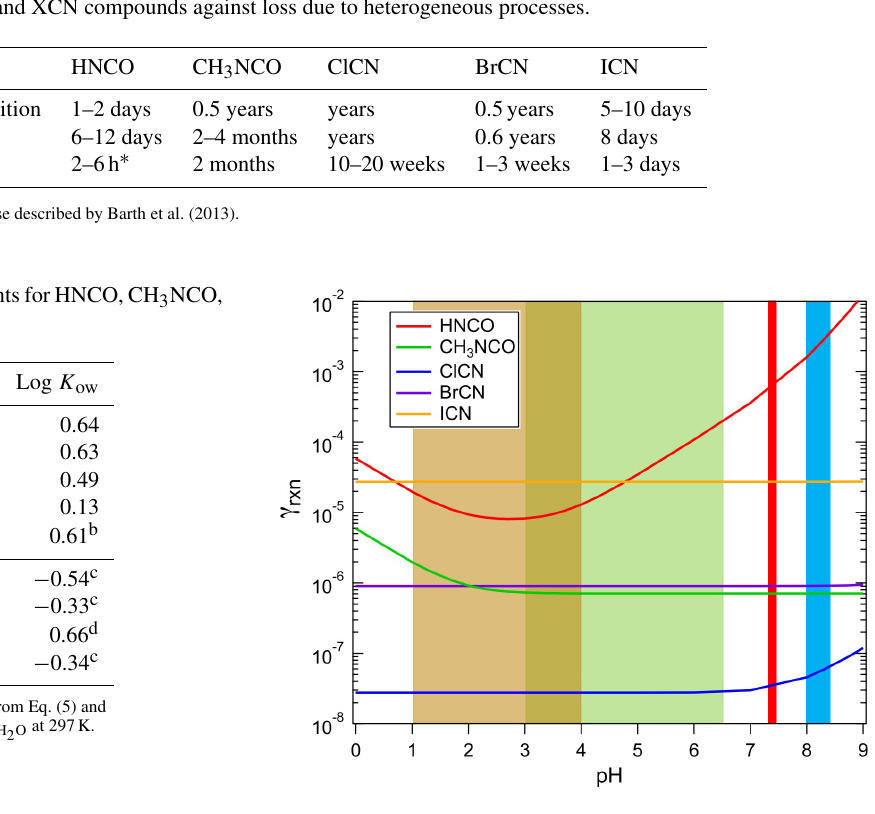
Figure 8. The uptake coefficients of HNCO, CH 3 NCO, ClCN, BrCN, and ICN as a function of pH for aqueous solution at ap- proximately 298K. The shaded areas show the range of pH charac- teristics of aerosols (light brown), cloud/fog water (green), human physiology (red), and ocean surface water (light